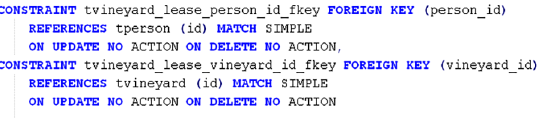
Figure 11. Definition of table relationships